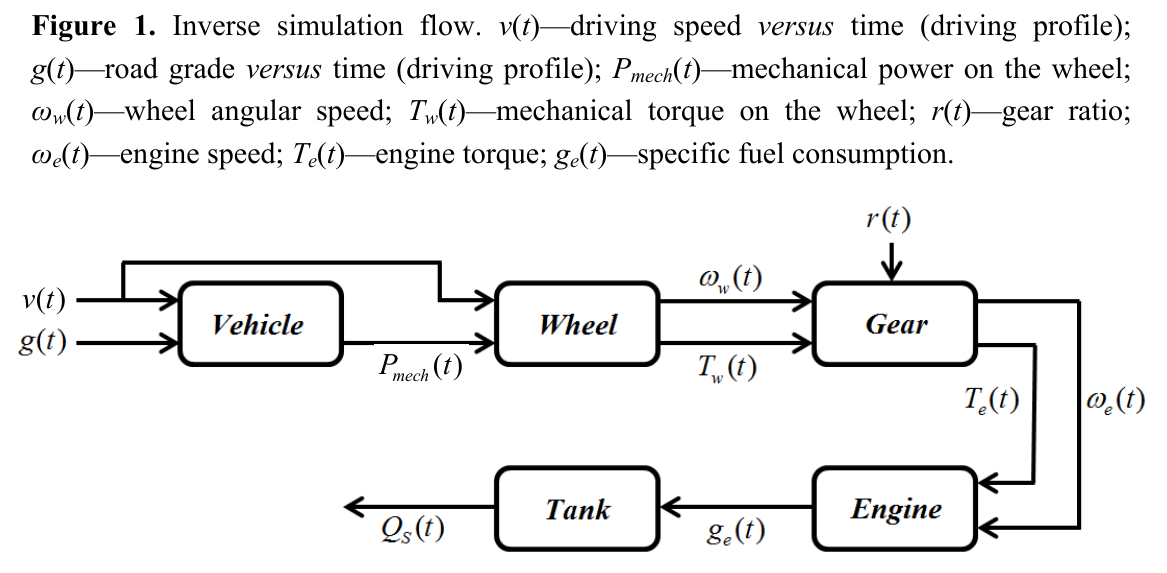
Figure 1. Inverse simulation flow. v ( t )—driving speed versus time (driving profile);